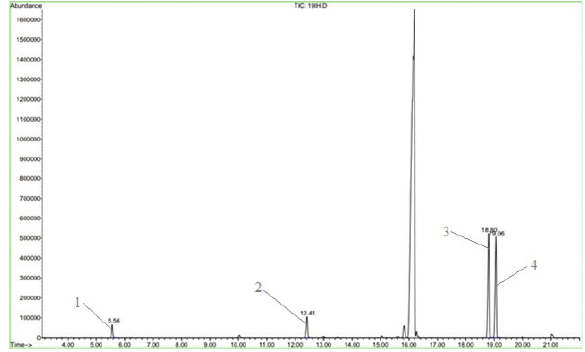
Figure 9. Chromatogram of carbohydrates formed as a result of enzymatic hydrolysis in the herbal mixture No. 19 (1 – arabi- nose, internal standard; 2 – glucose; 3–4 – fructose).